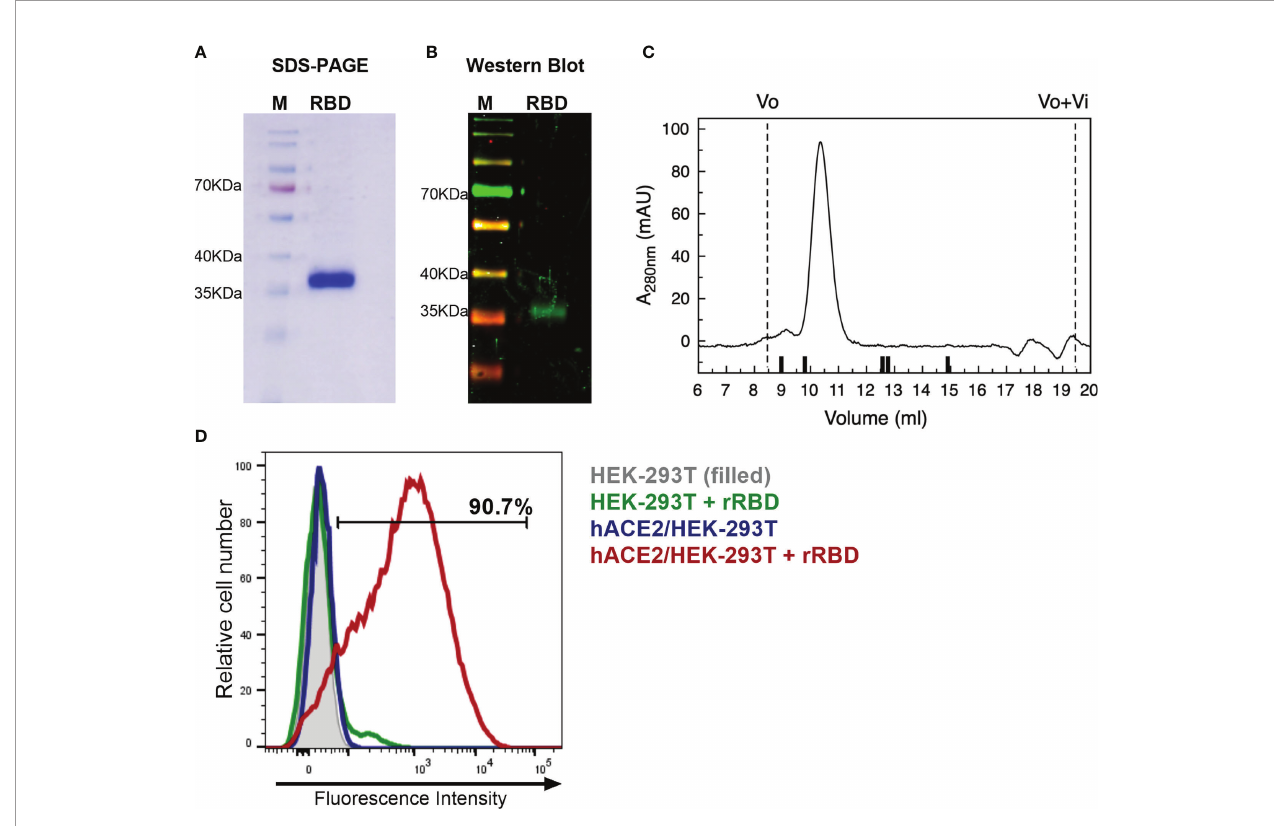
FIGURE 1 | Characterization of recombinant RBD. (A) Coomassie blue-SDS-PAGE stained of reduced RBD. M, page ruler. (B) Western Blot analysis of recombinant RBD produced in HEK-293 cells using a convalescent human serum as primary antibody. M, page ruler. (C) Representative size exclusion chromatography elution pro fi le of recombinant RBD. Black bars represent MWM; from left to right: BSA (66.4 kDa), OVA (44.3 kDa), papain (23 kDa), RNaseA (13.7 kDa), Aprotinin (6.5 kDa), and Vo and Vo+Vi are shown as dashed lines. (D) Binding of recombinant RBD (rRBD) to HEK-293T cells expressing hACE2. HEK-293T were used as control. Histograms and percentage of cells positive for RBD are shown. Results are representative of two independent